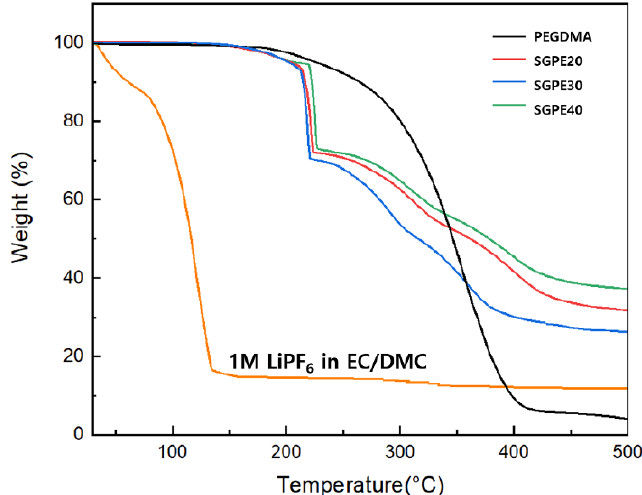
Figure 5. Thermal stability of pure PEGDMA, SGPEs, and 1M LiPF 6 in ethylene carbonate and dimethyl carbonate (EC/DMC). carbonate (EC /